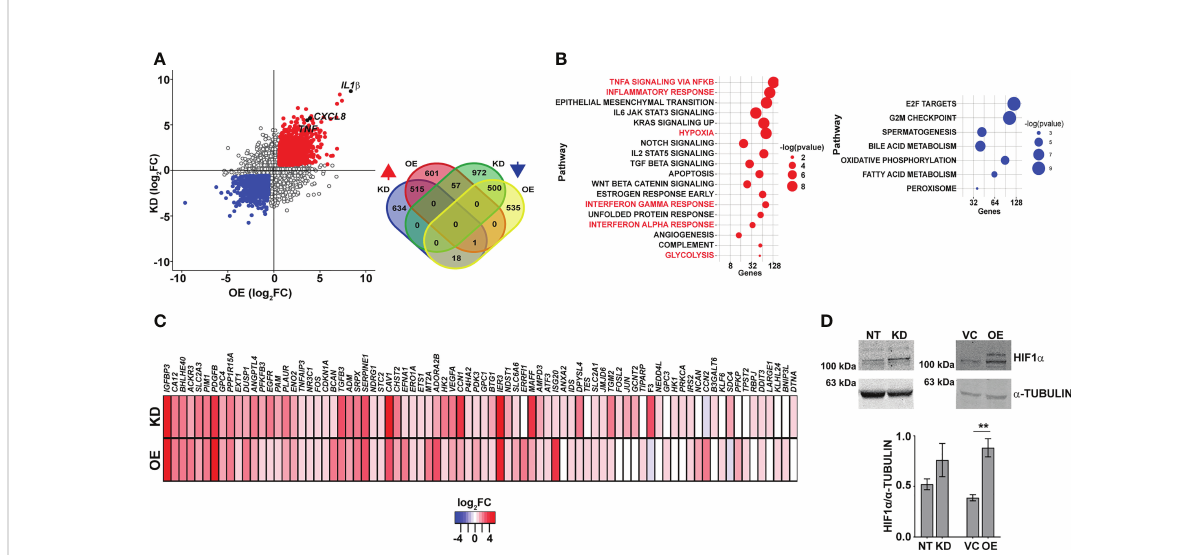
FIGURE 4 Macrophages with dysregulated CMPK2 display increased hypoxia. (A) Scatter plot of genes differentially expressed in KD or OE macrophages relative to the expression levels in the control macrophages (NT or VC), respectively. Change in expression is depicted as log 2 fold change in expression. The number of genes upregulated and downregulated in the macrophages is depicted as a Venn diagram (inset). (B) GSEA hallmark pathway enrichment analysis of the commonly upregulated and downregulated genes in the KD and OE macrophages are represented as a bubble plot. X axis is the number of genes of the pathway and size of the bubble depicts signi fi cance ( − log p-value). (C) Heat map of the hypoxia response gene expression in the CMPK2 dysregulated macrophages KD and OE. The values represent log 2 fold change from the corresponding control cells. (D) Analysis of HIF1 a in protein extracts of NT, KD, VC, and OE cells. Equal amounts of protein from the different extracts were probed with speci fi c antibodies, and a representative blot of three independent experiments is depicted. The change in expression level of HIF1 a with respect to a -TUBULIN was calculated by densitometric analysis and is graphically represented. GSEA, Gene Set Enrichment Analysis.